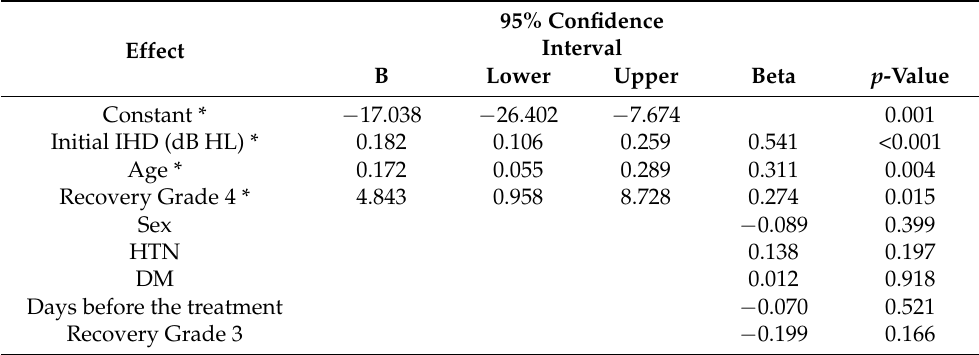
Table 3. Stepwise multiple linear regression model predicting the association between delayed hearing gain and the independent variables ( n =